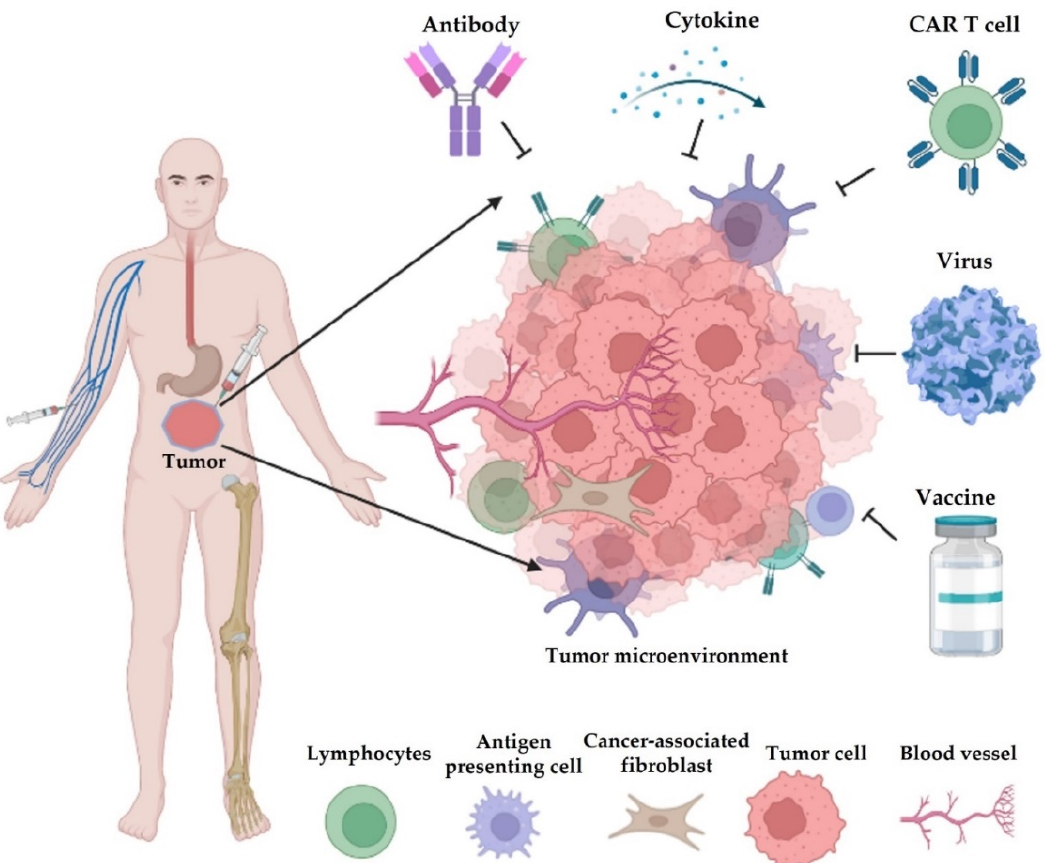
Figure 1. Different types of cancer immunotherapy. They mainly consist of blockade of immune checkpoints (e.g., antibody), adoptive transfer of engineered cells (e.g., chimeric antigen receptor (CAR) T cells, natural killer/NK cells, and macrophages), cytokine therapy, infection of oncolytic viruses, and cancer vaccines. Most of these therapeutics are administered by intravenous injection (i.v.), and some drugs are given by subcutaneous (s.c.), intraperitoneal (i.p.), or intramuscular (i.m.) injections.